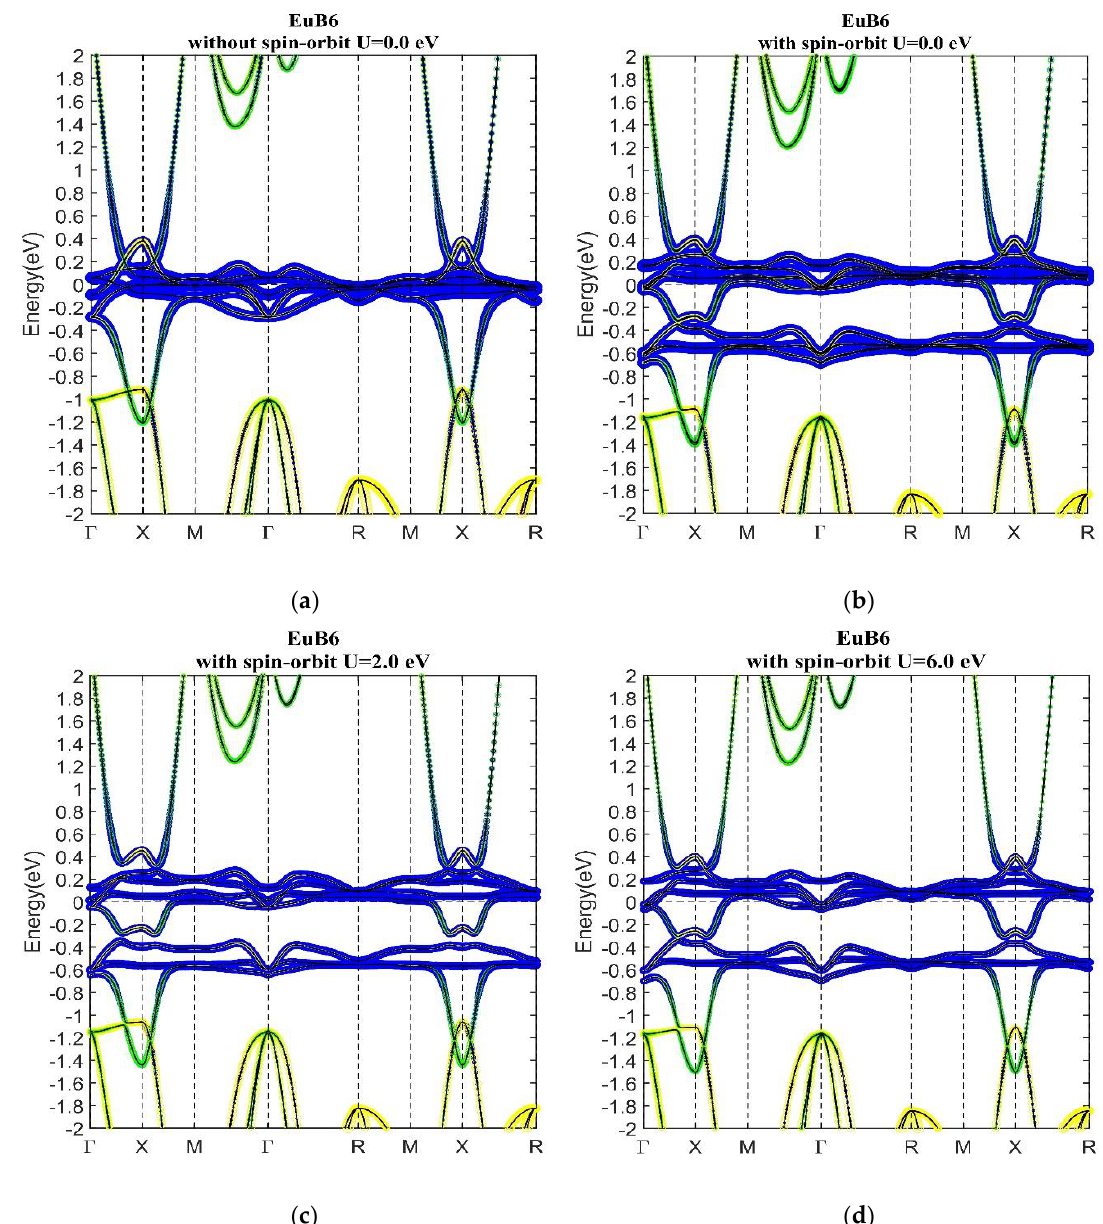
Figure 14. PBE band structure of EuB 6 without SOI ( a ) and with SOI ( b ). SOI opens up an energy gap around E f and induces band inversion around X point. PBE + U band structure of EuB 6 with on-site U = 2.0 eV ( c ) and U = 6.0 eV ( d ). Similar to SmB 6 , the Hubbard U does not change the band structure noticeably.